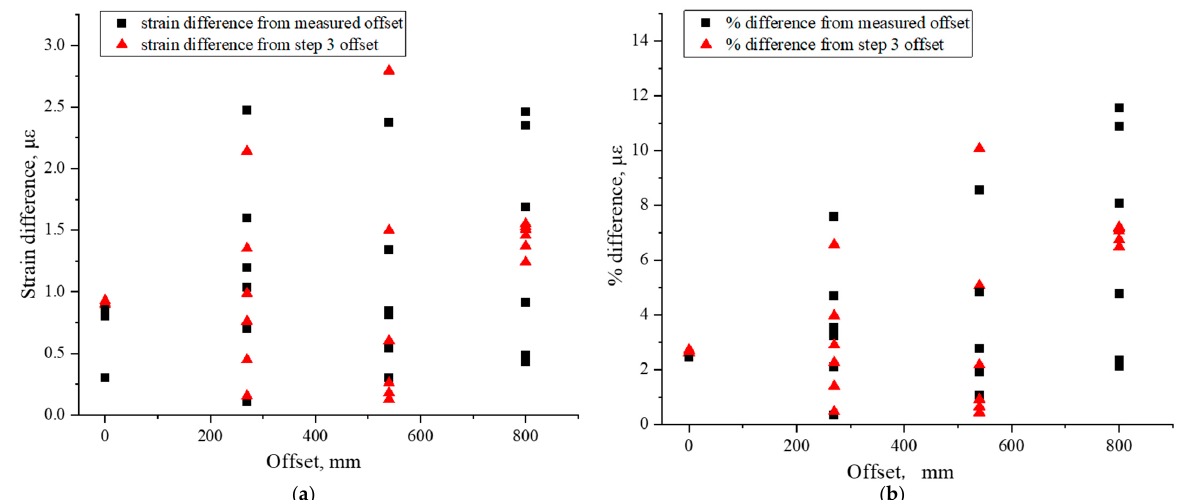
Figure 8. Difference between calculated and measured strains: ( a ) absolute difference and ( b ) %difference. Table 5. Results of one ‐ way analysis of variance between calculated and measured offsets.